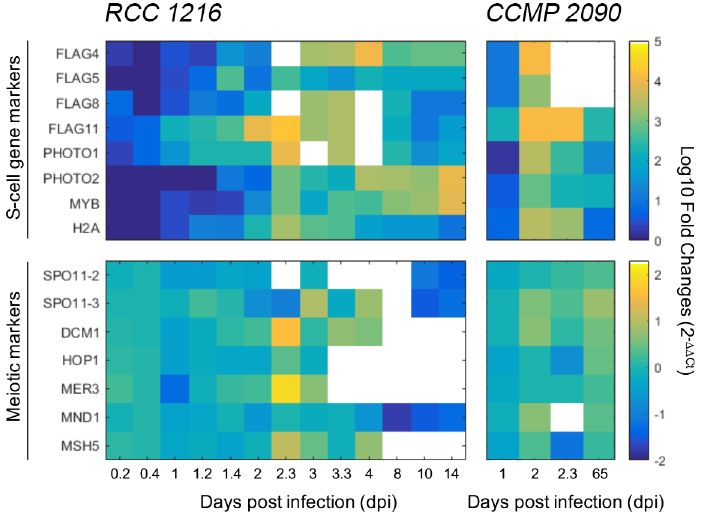
Fig 2. Gene-expression dynamics of meiosis- and life-phase-specific genes during EhV infection. Detailedexpressionprofiles of profilesof meiosis- and S-cell-specific for E . huxleyi RCC 1216and CCMP 2090 were performed by qPCR over the course of infectionand are presentedas heatmaps. The results are presented as Log 10 fold-change(2 - ΔΔ Ct ) relative to control, uninfectedcultures over time to enableof a clear visualizationof the expressiondata encompassing a large range of variability. Blank heatmapcells represent time points with undetected gene expressionlevels. Gene expressionwas undetected for days 6 and 7 and therefore this time periodwas removedfrom the heatmap (gene expression data is availablein S2 Table). The mean values of duplicatecultures are